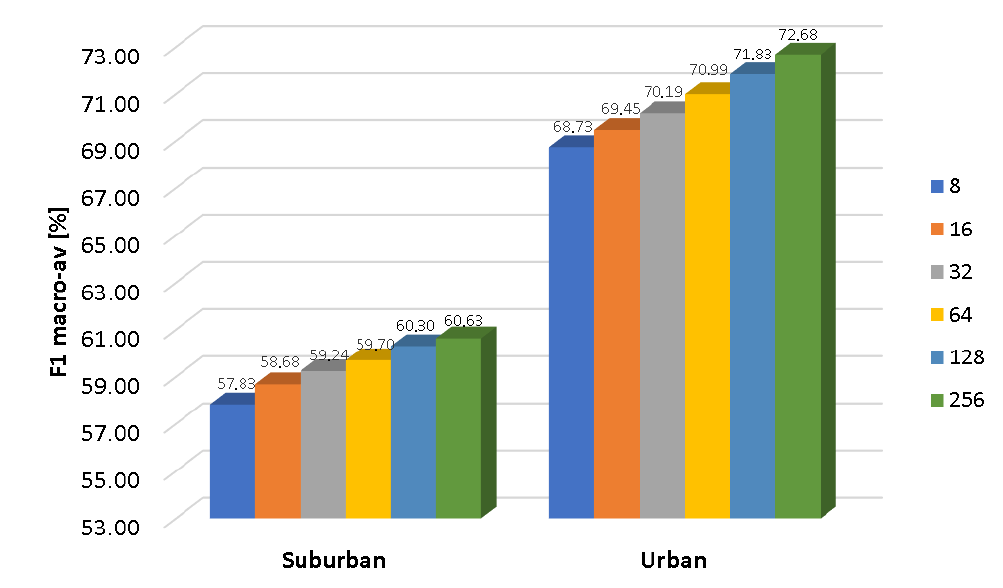
Figure A4. GMM optimization results using the real-life suburban and urban databases, respectively. In each experiment, a different number of Gaussian components has been set, which is shown in the